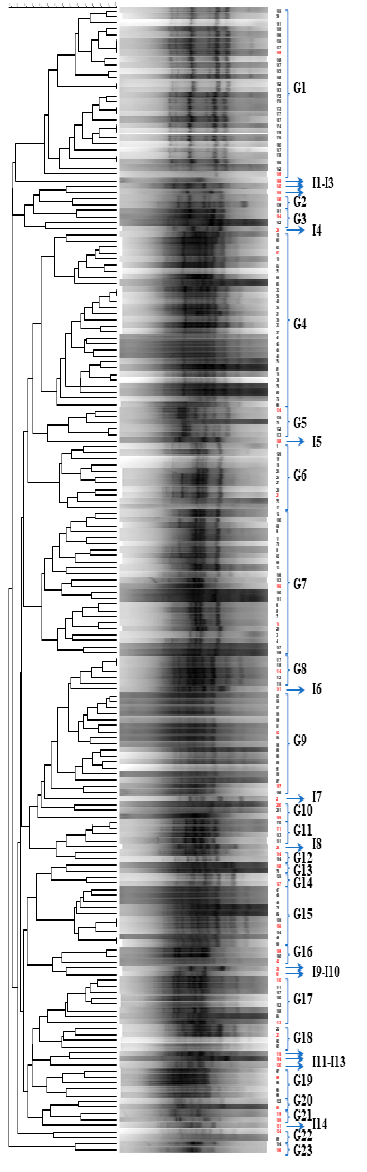
Figure 1. Cluster analysis of PCR-RAPD patterns of bacterial isolates, obtained from nine dairy samples. Distance is indicated by the mean correlation coefficient [r (%)] and clustering was performed by UPGMA analysis. The representative strains selected for 16S rRNA gene sequencing are in